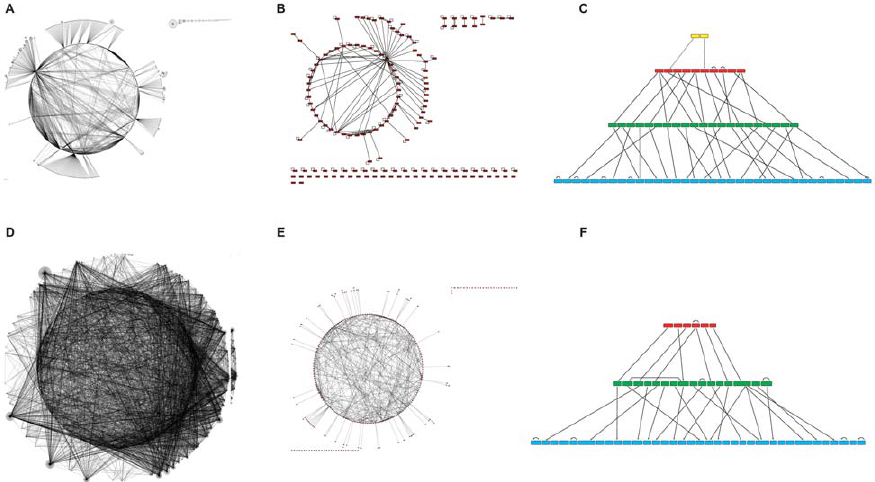
Figure 5. From the gene regulatory network (GRN) to the hierarchical structure. Illustration of ( A ) the GRN of E. coli with 1095 nodes and 2044 edges and ( D ) the GRN of S. cerevisiae with 3458 nodes and 8371 edges. Red nodes indicate transcription factors, green nodes genes. For extracting the hierarchical structure we deduced transcriptional regulation only. The transcriptional regulatory networks (TRNs) are shown in ( B ) for E. coli and ( E ) S. cerevisiae only. A snapshot of the hierarchical structure of the TRNs is shown for E. coli in ( C ) and for S. cerevisiae in ( F ). The TRN of E. coli has a four-layered pyramidal-shaped hierarchical structure, whereas the TRN of S. cerevisiae consists only of three layers. The different colors represent the distinct hierarchical levels: level 4– yellow; level 3– red; level 2– green; level 1– blue.